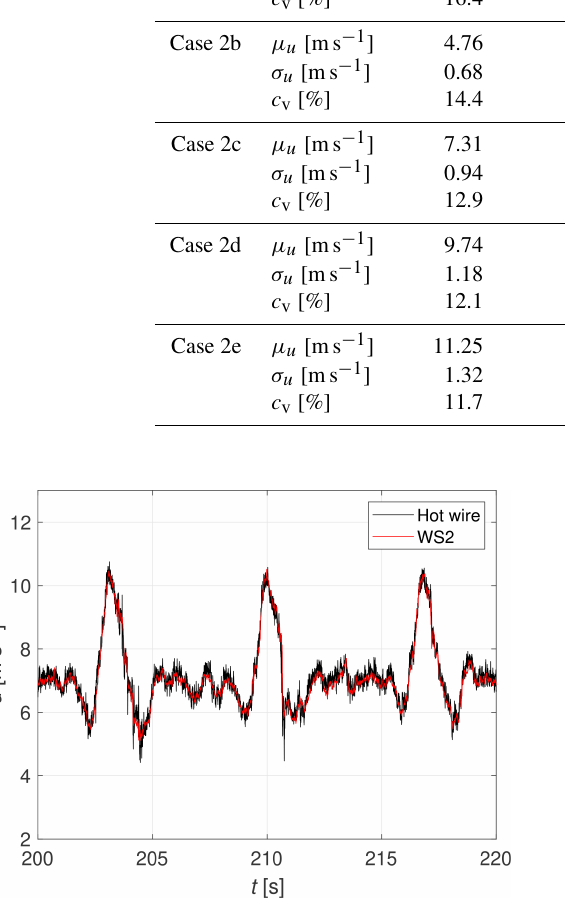
Figure 15. Snapshot of the 10min time series measured by Wind- Scanner 2 and the hot-wire anemometer for a coefficient of variation of 12.9% (Case 2c).